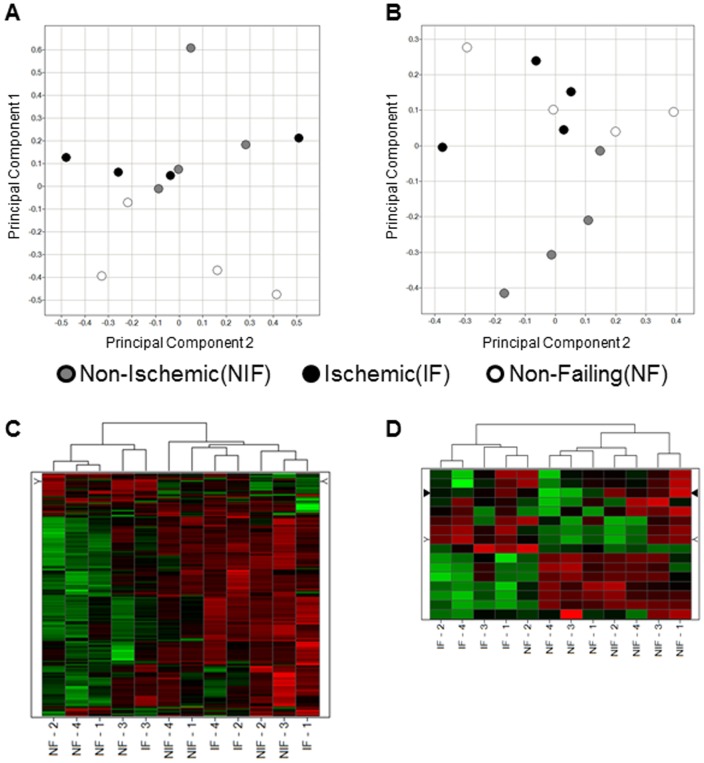
Principal Components Analysis and Hierarchical Clustering.The expression data for all peptides from the unenriched (A) and phosphopeptide enriched (B) samples were used to perform Principal Components Analysis (PCA) after z-score transformation of the peptide intensities. The top two principal components are plotted in each figure, showing no extreme outlier samples among the twelve individual patients tested, either among the unenriched samples or phosphopeptide-enriched. The statistically-significant differentially expressed peptides for each experiment were used to calculate 2D hierarchical clusters in order to view sample-to-sample relationships within these differentially expressed signals, at the unenriched proteome level from Tables 2 and 3 (C) and from the phosphoproteome in Table 4 (D).